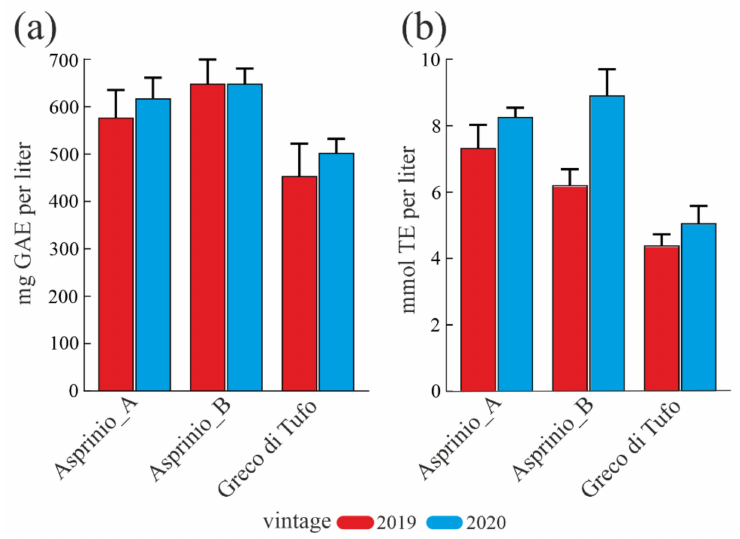
Figure 1. Total phenol content and antioxidant capabilities in ‘Asprinio_A’, ‘Asprinio_B’ and ‘Greco di Tufo’, considering the 2019 and 2020 vintages. ( a ), total phenol content (TPC) expressed as mg of gallic acid equivalents (GAE) per L of each wine ± SD. ( b ) Trolox equivalent (TE) antioxidant activity from ORAC assay expressed as mmol of Trolox equivalents (TE) per L of each wine ± SD.